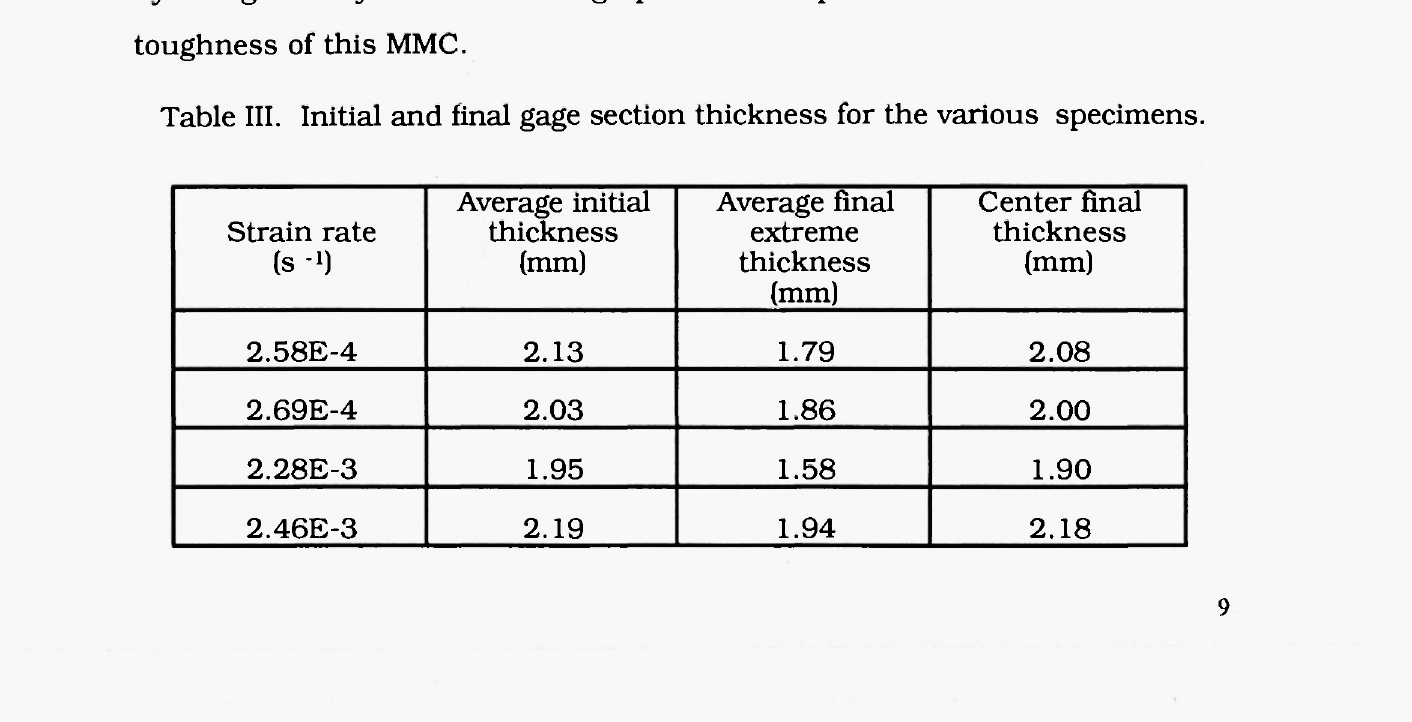
Table III. Initial and final gage section thickness for the various